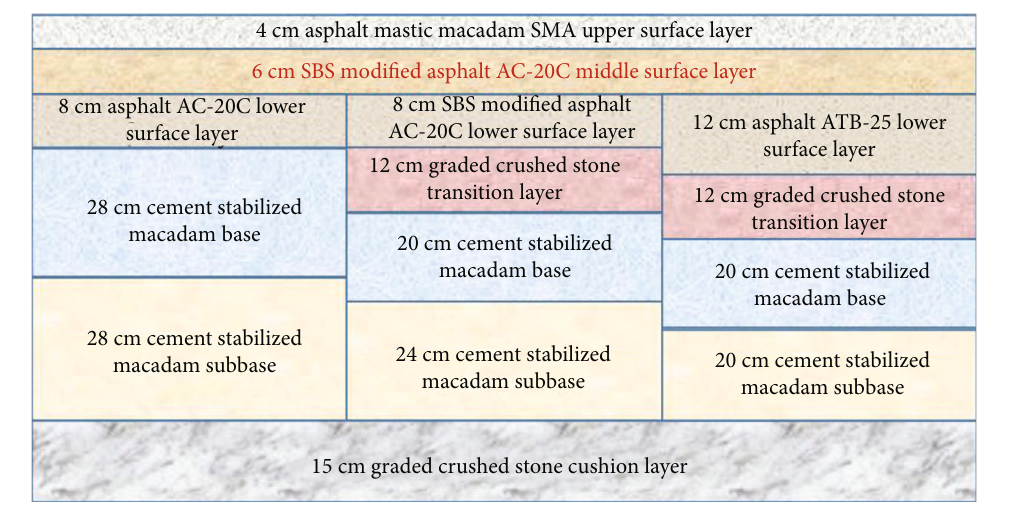
Figure 1: The test section pavement